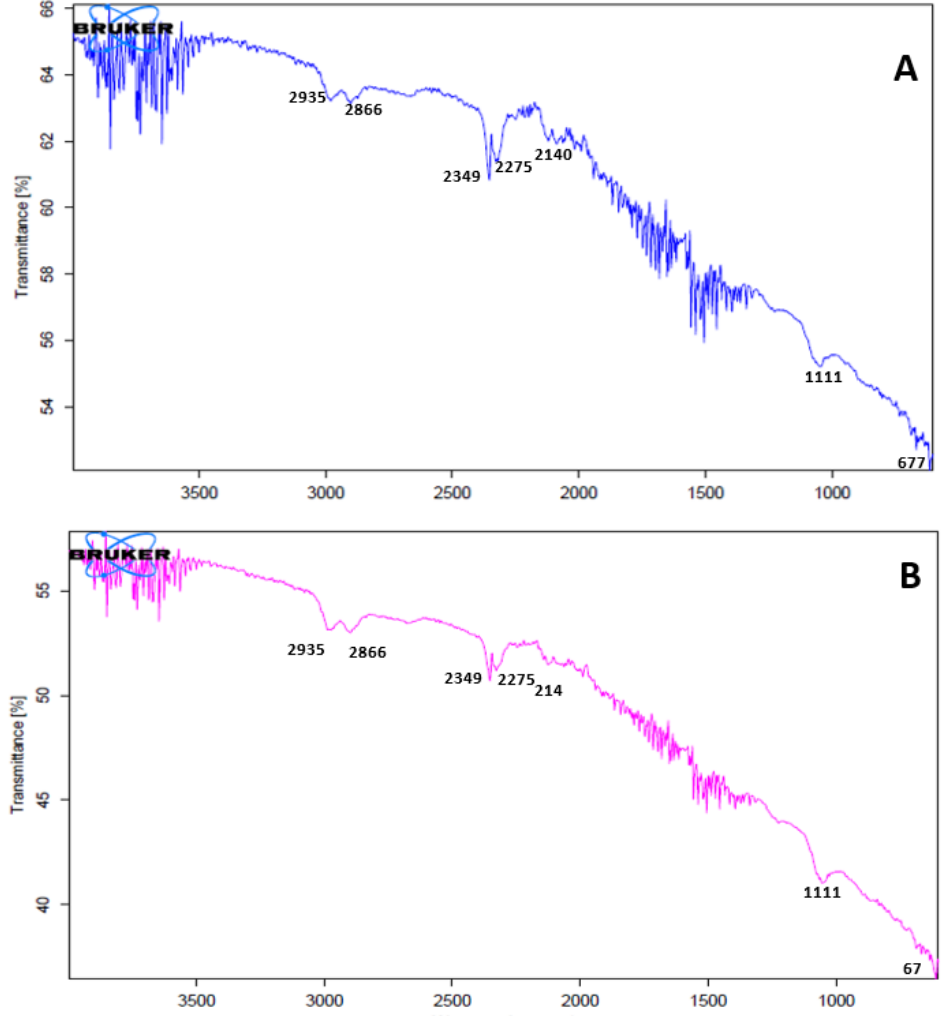
Figure 3. Fourier transform infrared (FT-IR) spectrum of C. carandas leaf extract-mediated biosynthesized silver at 25 °C ( A ) and at 60 °C ( B ).